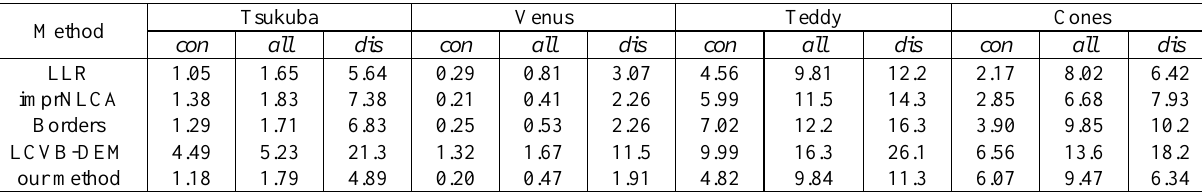
Table 1. Comparison of results with error threshold 1.0